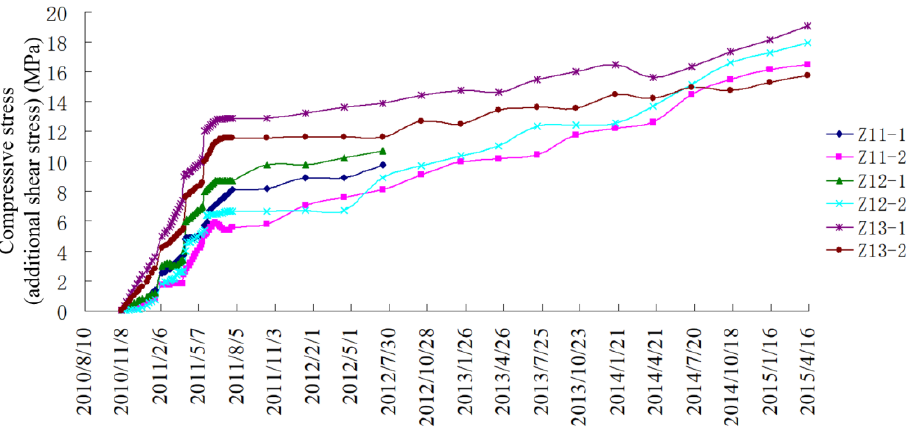
Figure 17. The stress–time curve of each measuring point of fault F2 monitored by the borehole stress meter.